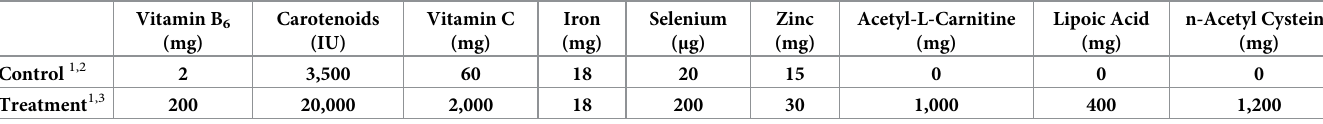
Table 1. Micronutrient dose per 16 capsules (actual daily dose) of indicated micronutrients in control or treatment